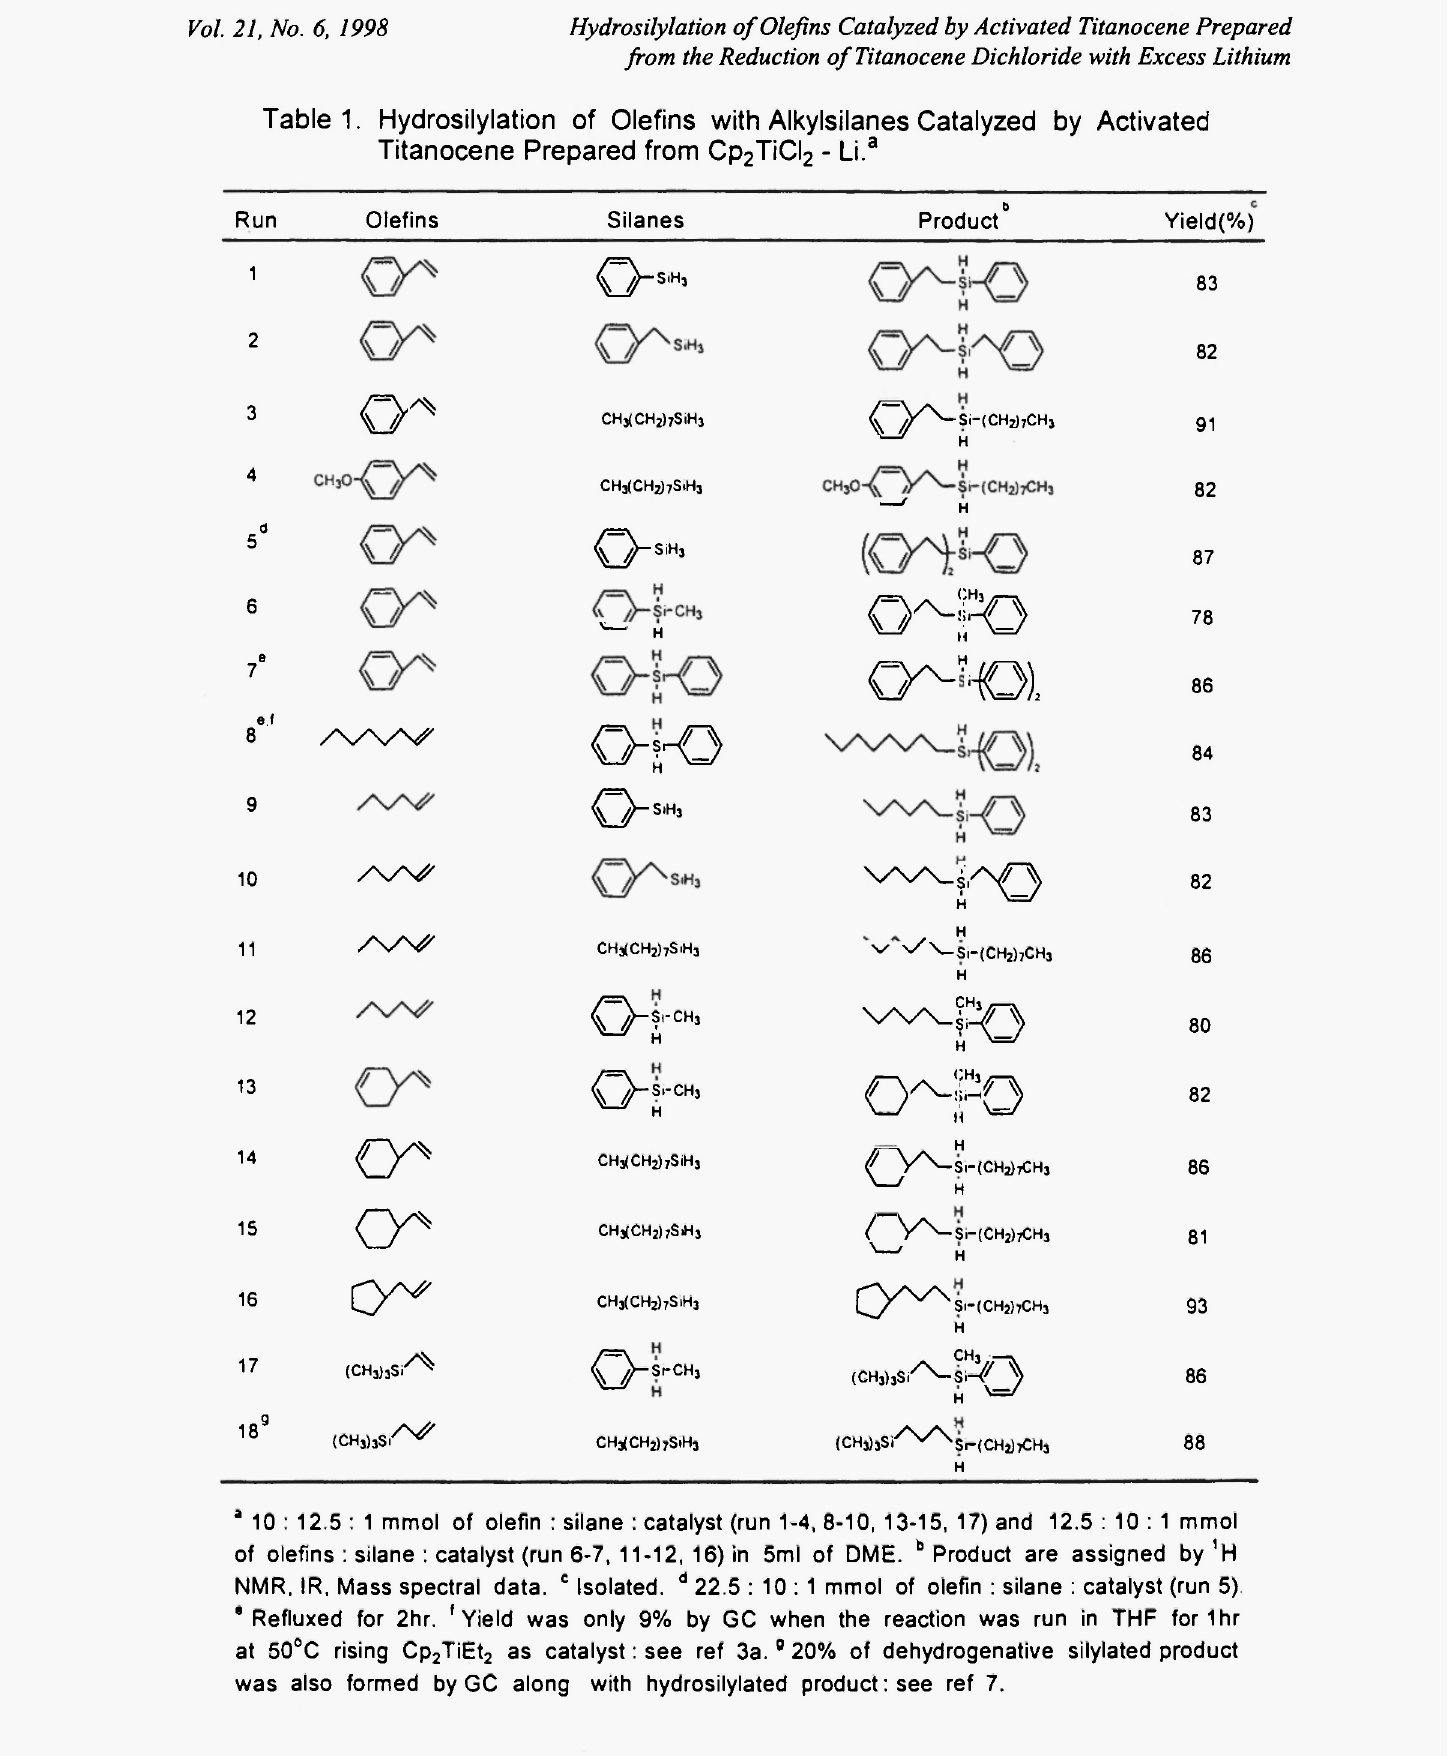
Table 1. Hydrosilylation of Olefins with Alkylsilanes Catalyzed by Activated Titanocene Prepared from Cp